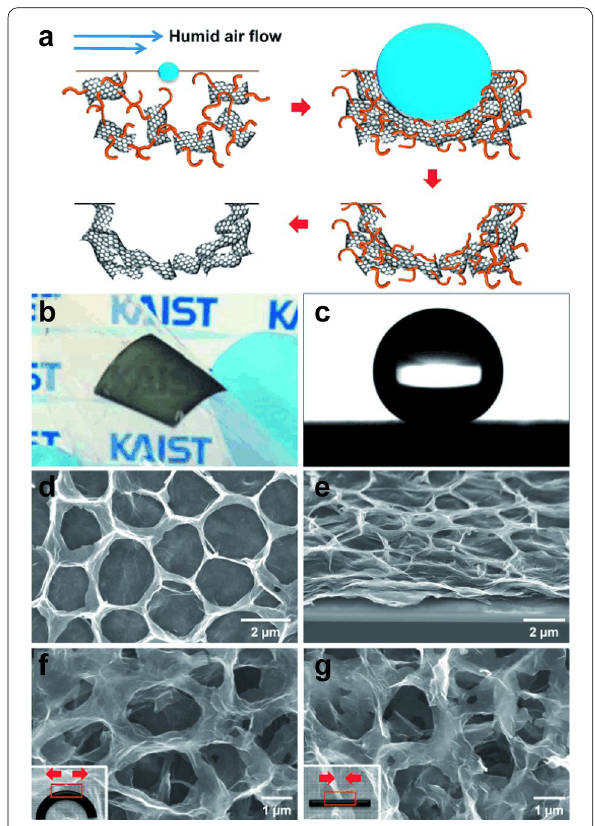
Fig. 2 a Diagram illustrating the assembly of modified GO into the carbon films using breath‑figure method. b A photograph of a flex‑ ible semi‑transparent macroporous RGO film on PET. c A water drop on macroporous RGO film. d , e , f , and g Plane‑view and tilted SEM images of an RGO film (Reprinted with permission